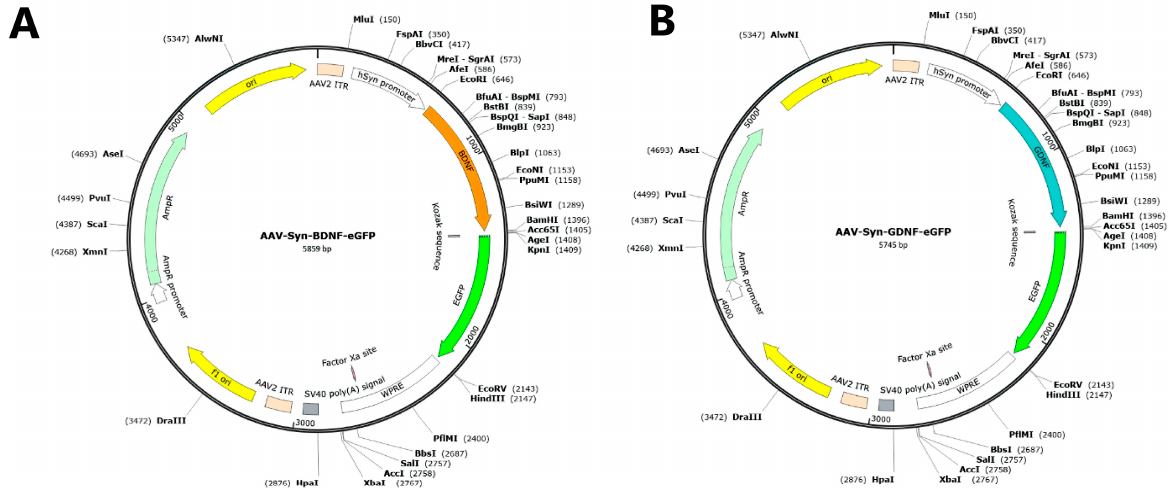
Figure 1. Maps of pAAV-Syn-BDNF-eGFP ( A ) and pAAV-Syn-GDNF-eGFP ( B ) plasmid vectors (constructed using the SnapGene Viewer 3.1.2 software (from Insightful Science; available at snapgene.com) (GSL Biotech LLC, San Diego, CA, USA).